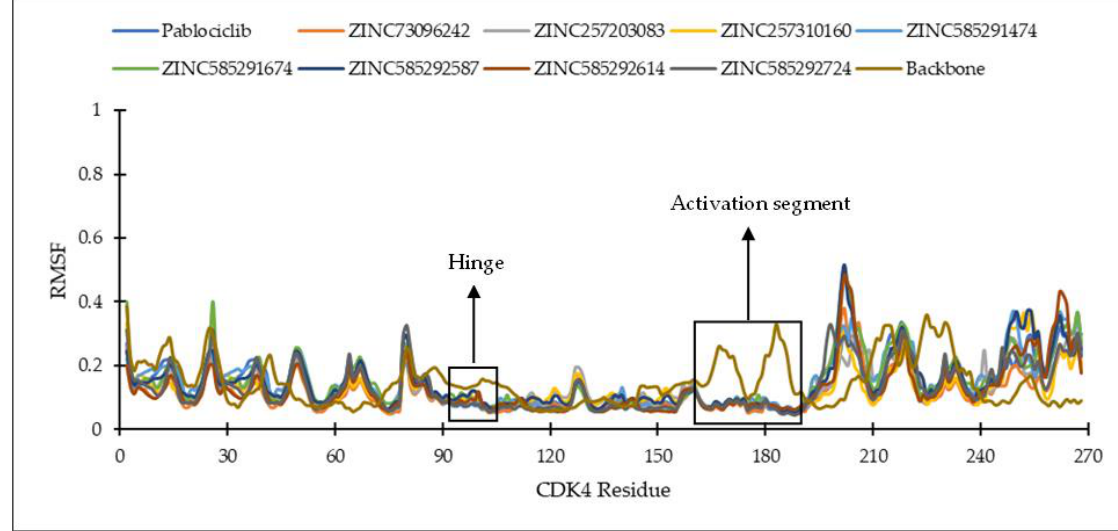
Figure 6. The RMSF of the amino acid residue of CDK4 during the MD simulation.